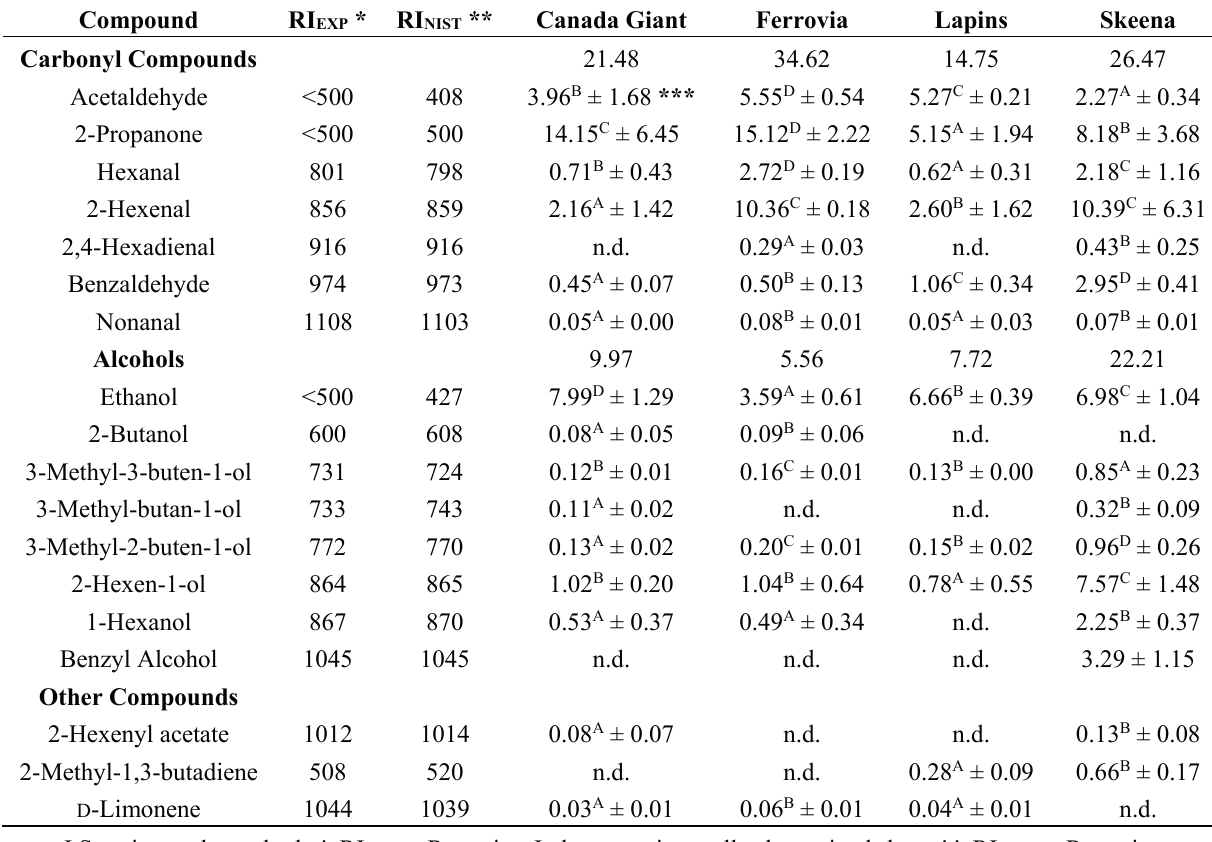
Table 2. Identification and semi—quantification of volatile compounds (data are expressed as µg of I.S./kg